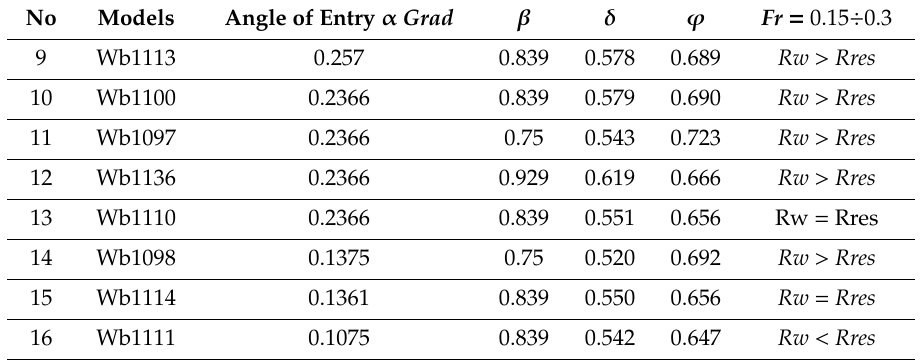
Table 2. Comparison of the relative position of the main part of the calculated Michel’s curves and the experimental curves of the residual resistance (Weinblum’s models).